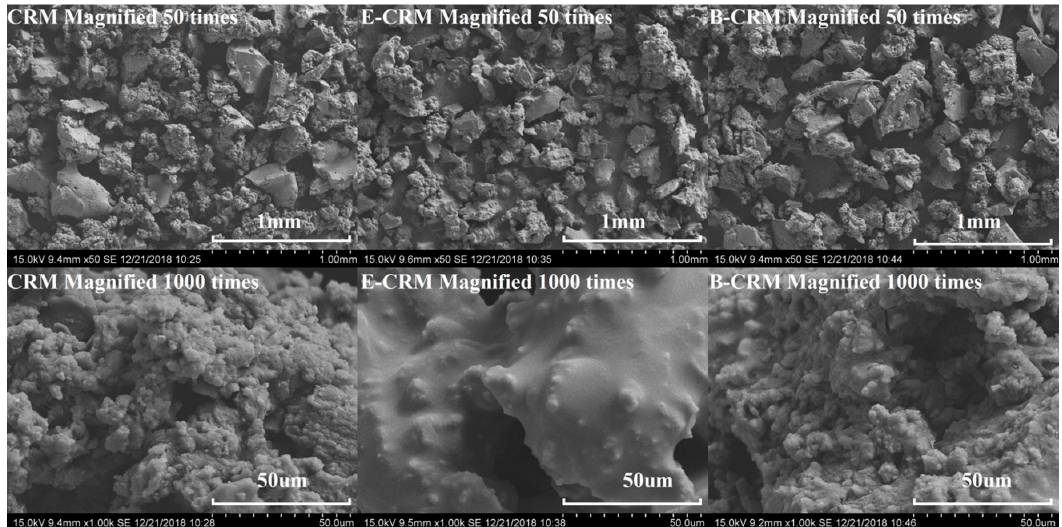
Figure 10. SEM results: variations of CRM before and after soaking in Evotherm–DAT or HBO.